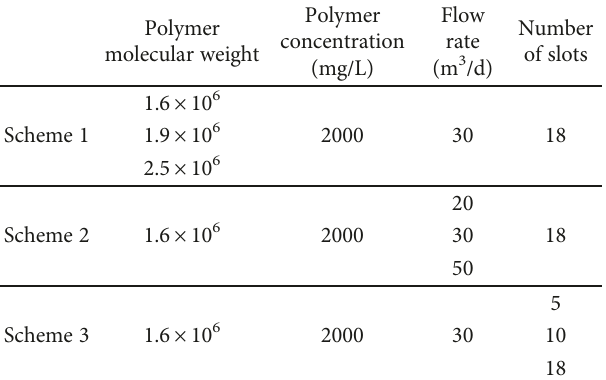
Table 1: Experimental schemes of the PIV test. Polymer molecular weight